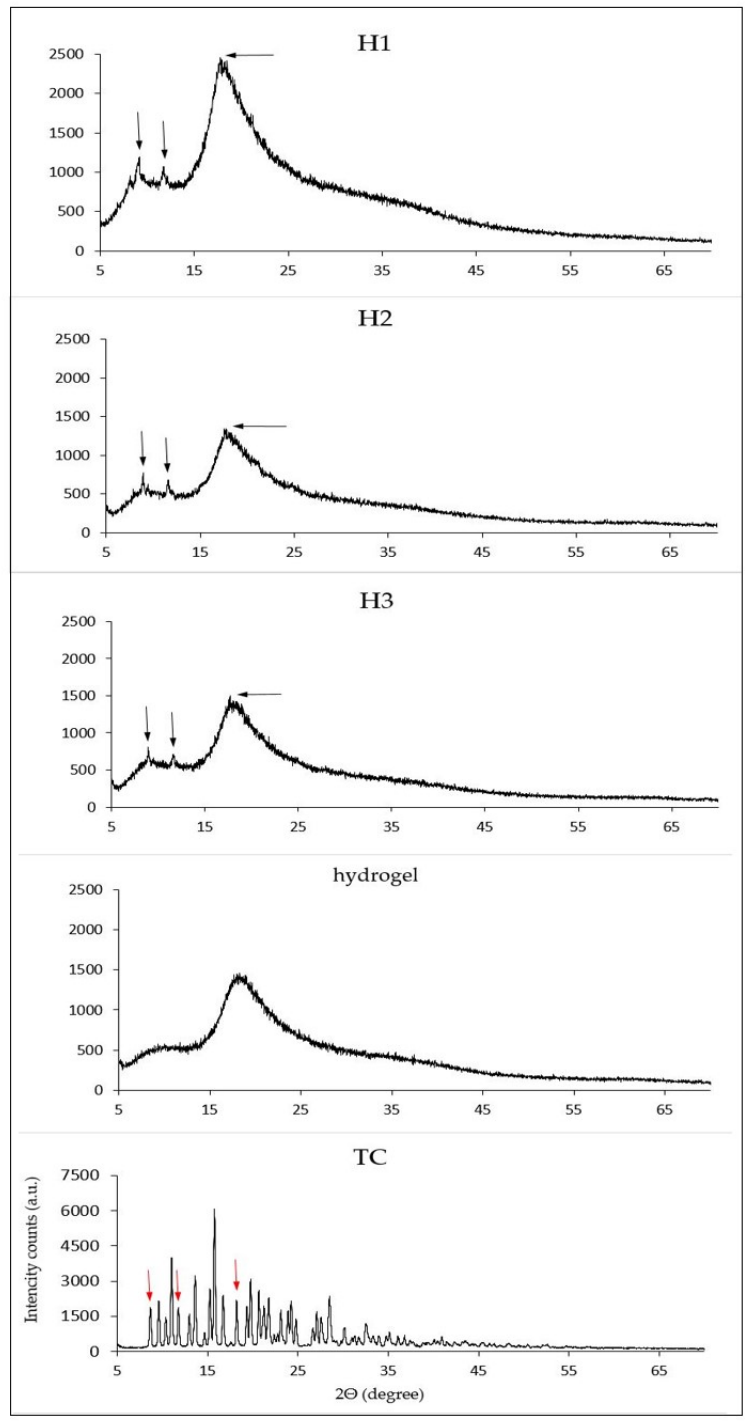
Figure 6. Powder X -ray diffraction patterns for investigated samples H1, H2 and H3, hydrogel Figure 6. Powder X-ray diffraction patterns for investigated samples H1, H2 and H3, hydrogel sam- sample without TC and commercial ple without TC and commercial TC.